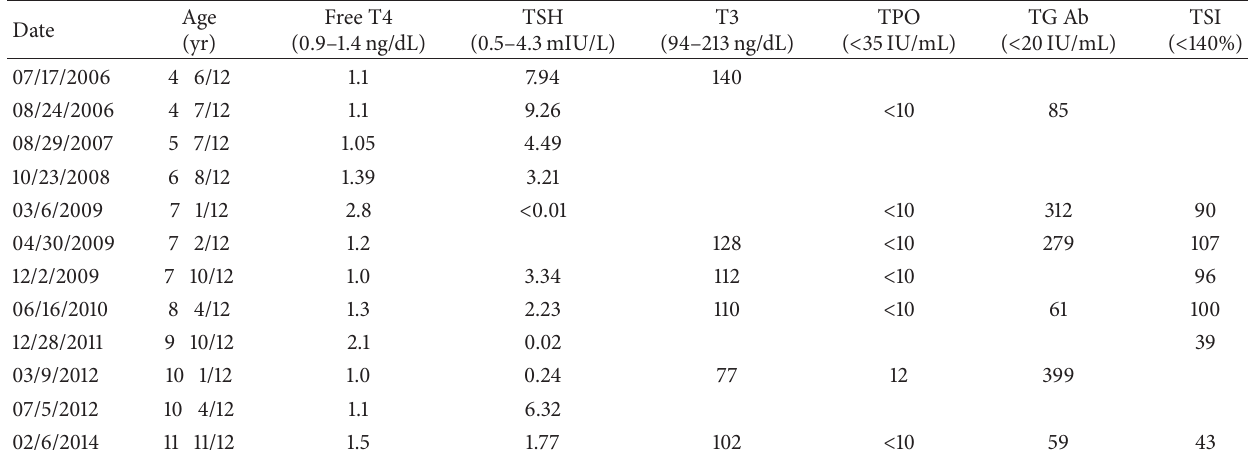
Table 1: Initial and follow-up laboratory